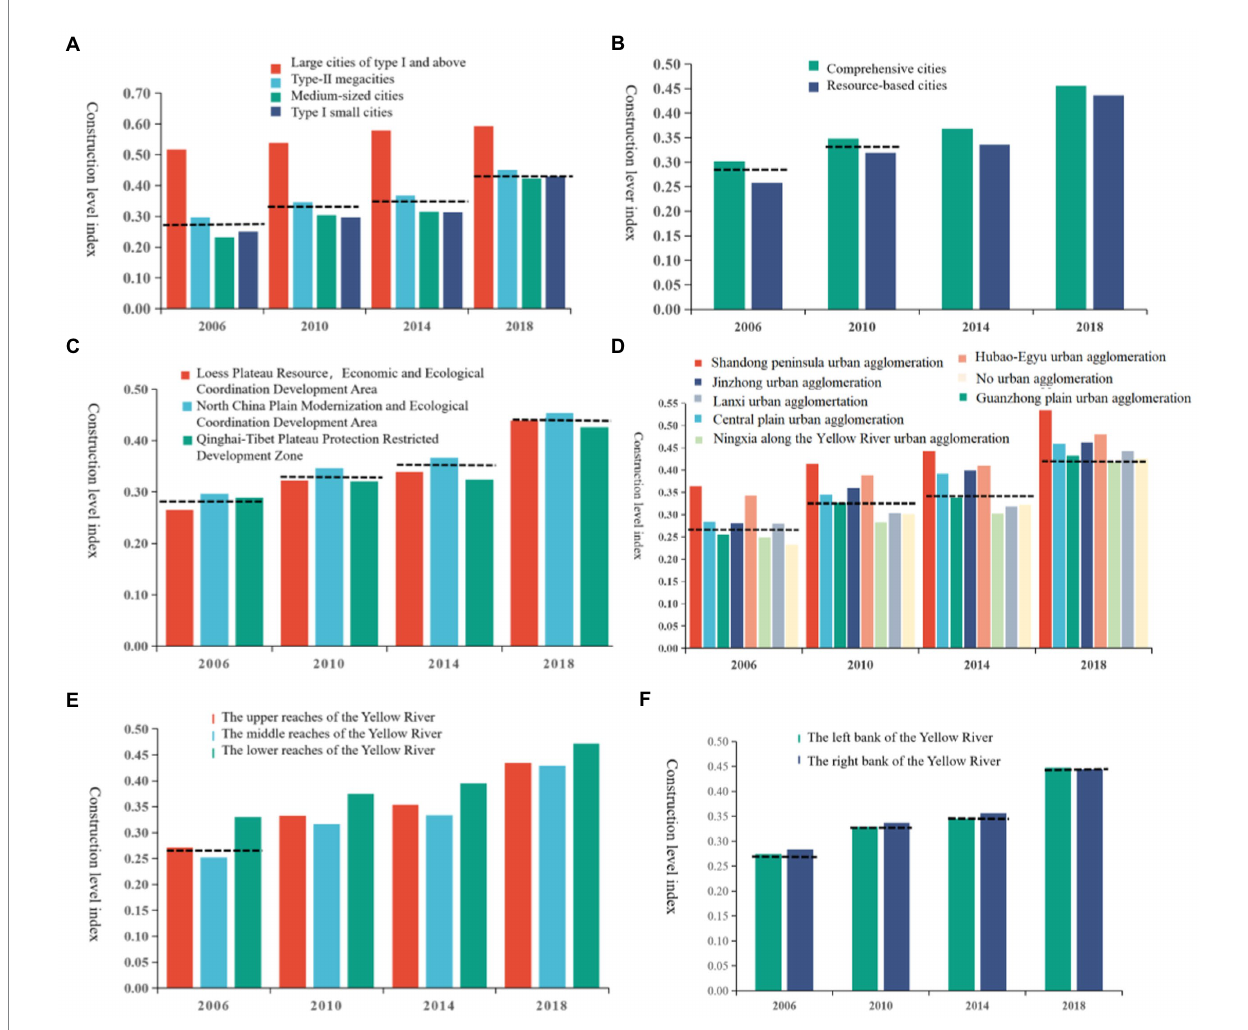
FIGURE 5 Ecological construction levels for various categories of cities in the Yellow River basin. A : urban ecological construction level of different scale cities; B : urban ecological construction level of different functional types of cities; C : urban ecological construction level of “three areas”; D : urban ecological construction level of “seven urban agglomerations”; E : urban ecological construction level of upper, middle and lower reaches of the Yellow River Basin; F : urban ecological construction level of the left and right bank of the Yellow River Basin. Dashed line shows data for average value of ecological construction in all dimensions in the Yellow River